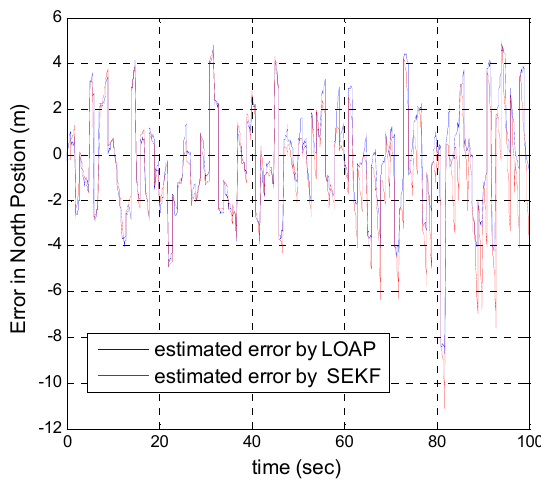
Figure 5. Error estimation of north position.